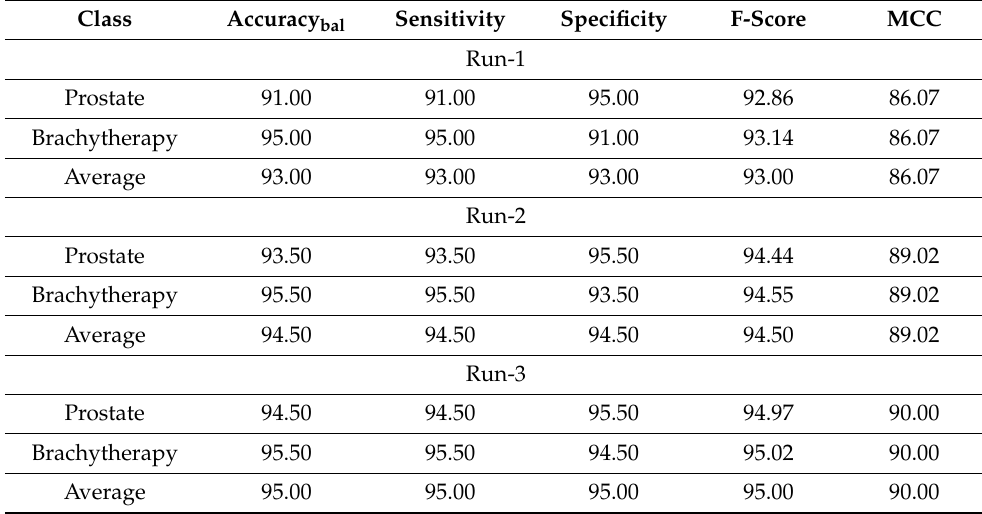
Table 2. Analytical results of the AOADLB-P2C system under distinct measures and runs.